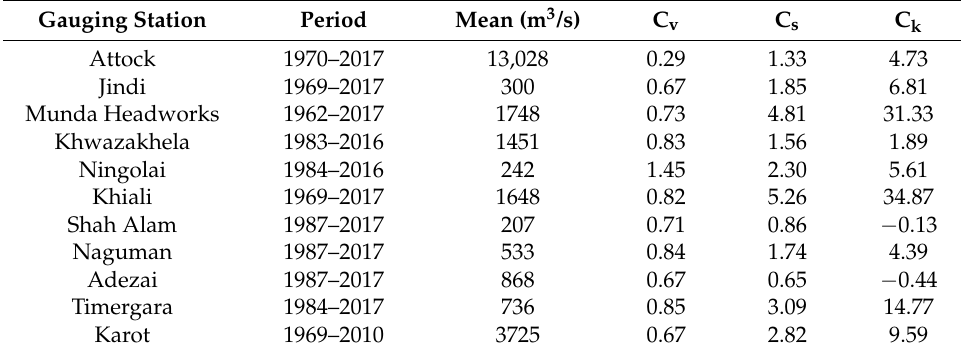
Figure 1. Location map of flow gauging stations and rivers and digital elevation of the study area. Table 1. Summary statistics of annual maximum (AM) flood series